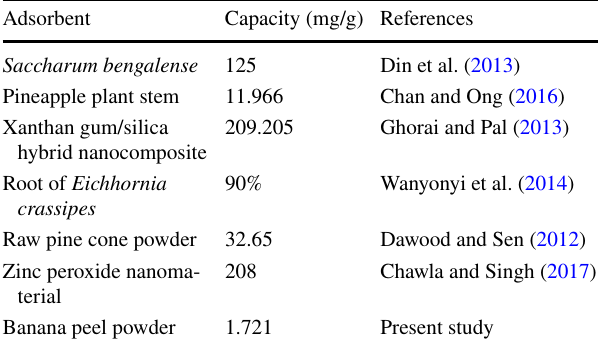
Table 4 Comparative study of Congo red adsorption performance